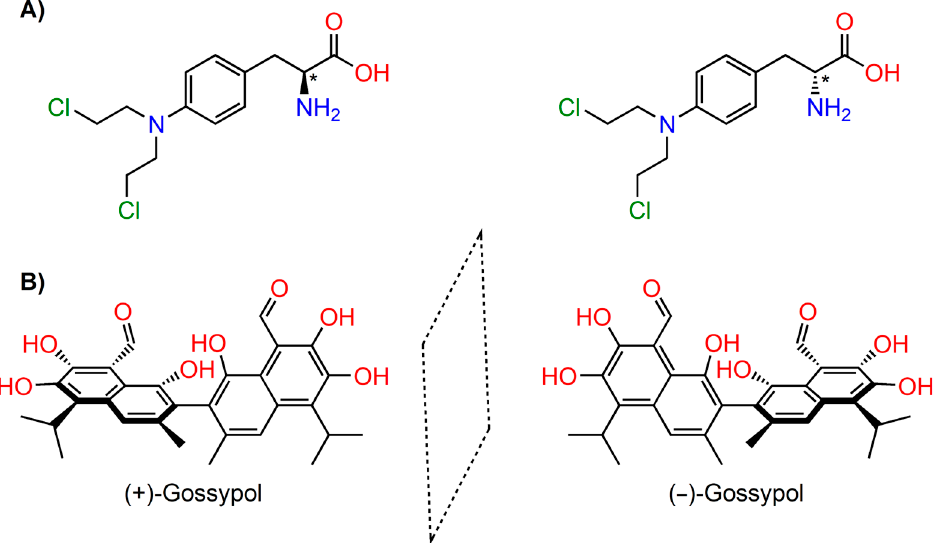
Figure 4. Examples of enantiomeric pairs in the group of chiral anticancer compounds [43,44]. ( A ) Melphalan carrying the stereogenic centre (marked with asterix)—carbon with four different atoms or groups. ( B ) Gossypol stereoisomers resulting from atropoisomerism. Stereoisomers are denoted according to the configuration of stereogenic centre ( R )- ( S )-, or their optical activity (+), ( − ).